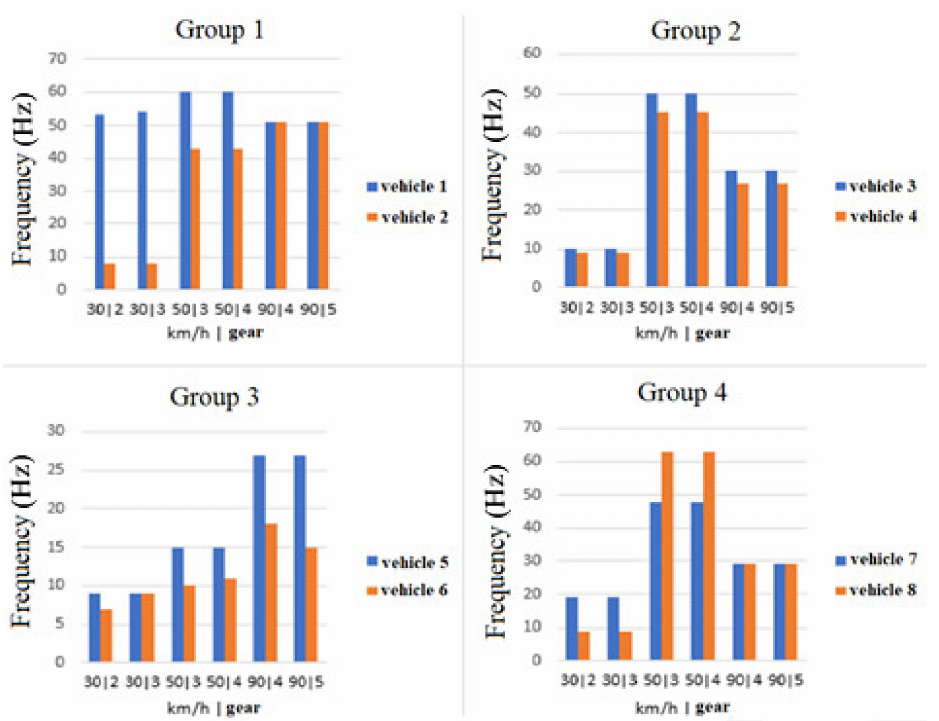
Figure 6. Comparison of the dominant harmonic vibrations’ values measured at the steering wheel in each group; for the older (blue) and the newer models (orange).